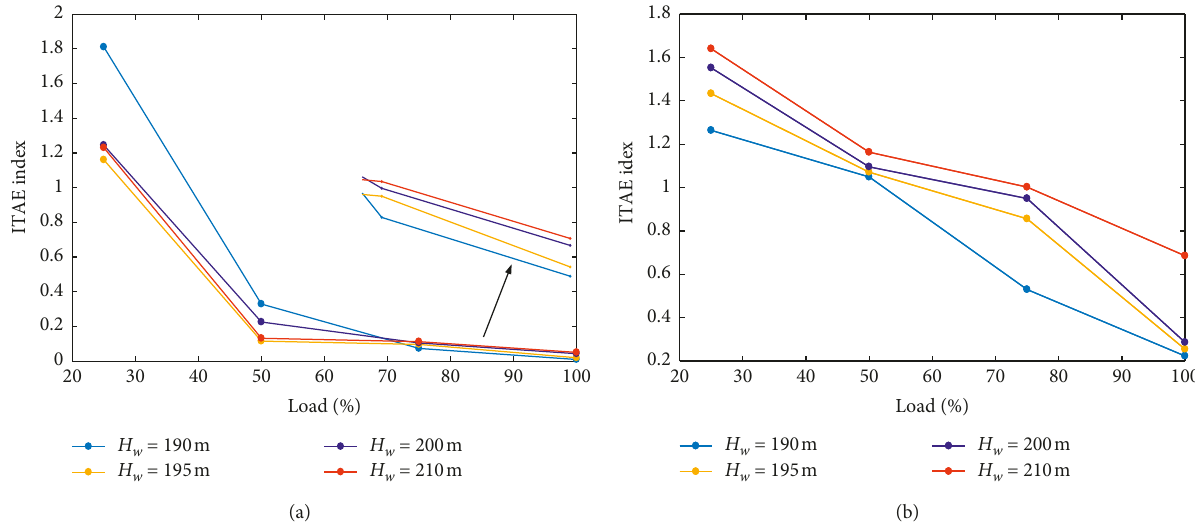
Figure 5: The comprehensive ITAE index of different water heads with different loads. (a) Δ f � − 0 . 5Hz. (b) Δ f � − 0 . 2Hz.